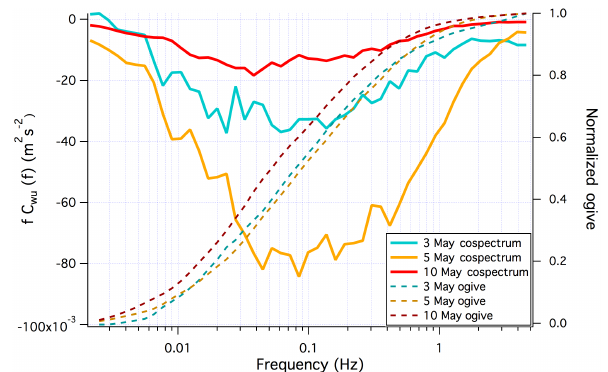
Figure A1. Mean momentum cospectra and normalized Ogives on 3, 5, and 10 May 2015 (R3 sonic anemometer). Mean wind speeds were 12, 17, and 6ms − 1 on these three